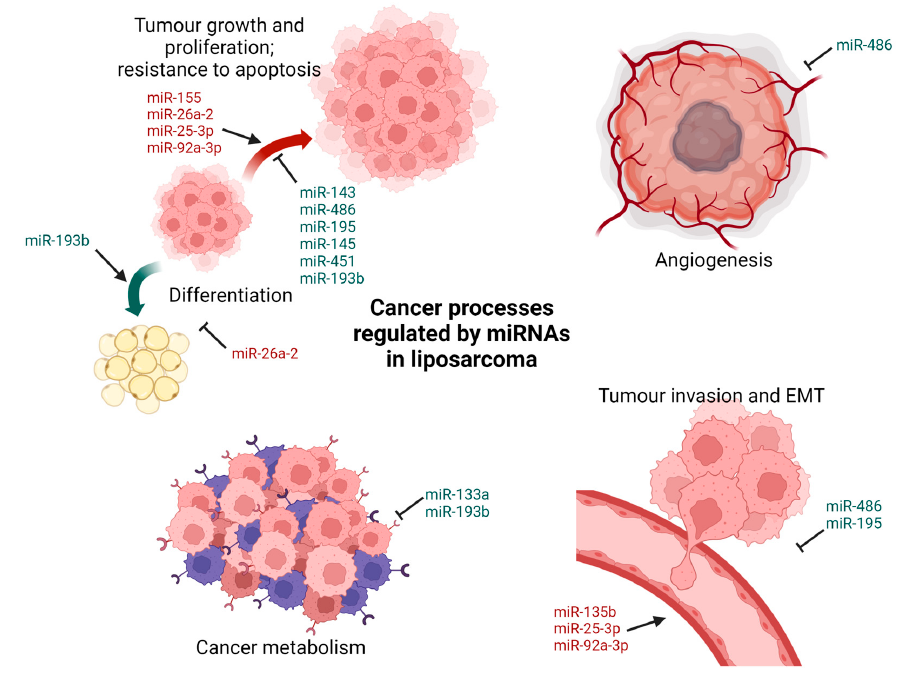
Figure 3. microRNAs involved in the regulation of